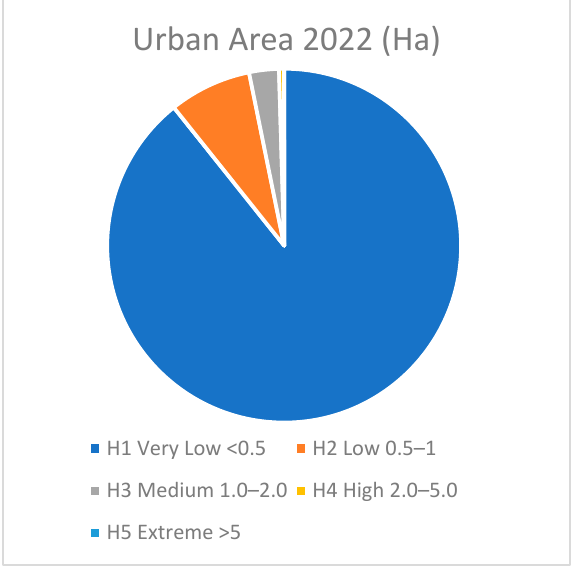
Figure 15. Distribution of urban areas exposure over hazard classes for 2022.